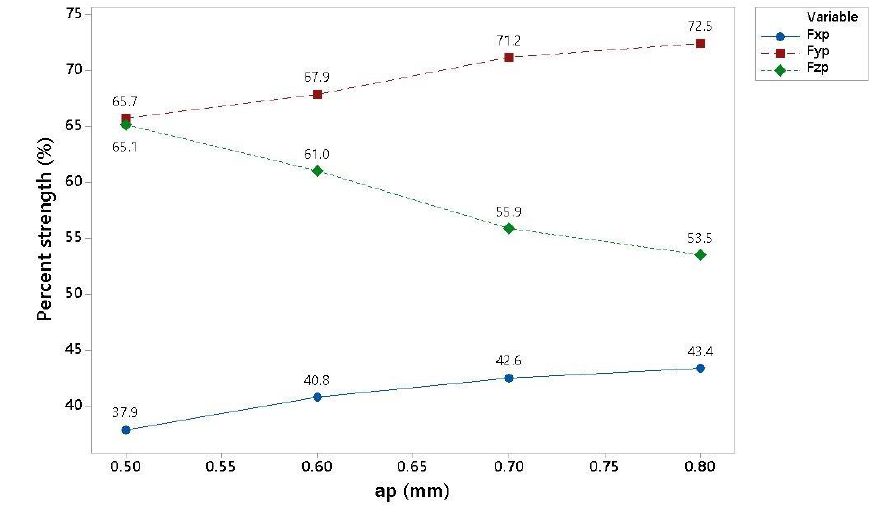
Figure 6. Graphical representation of fz = 0.6 mm/tooth and vc = 180 mm/min.